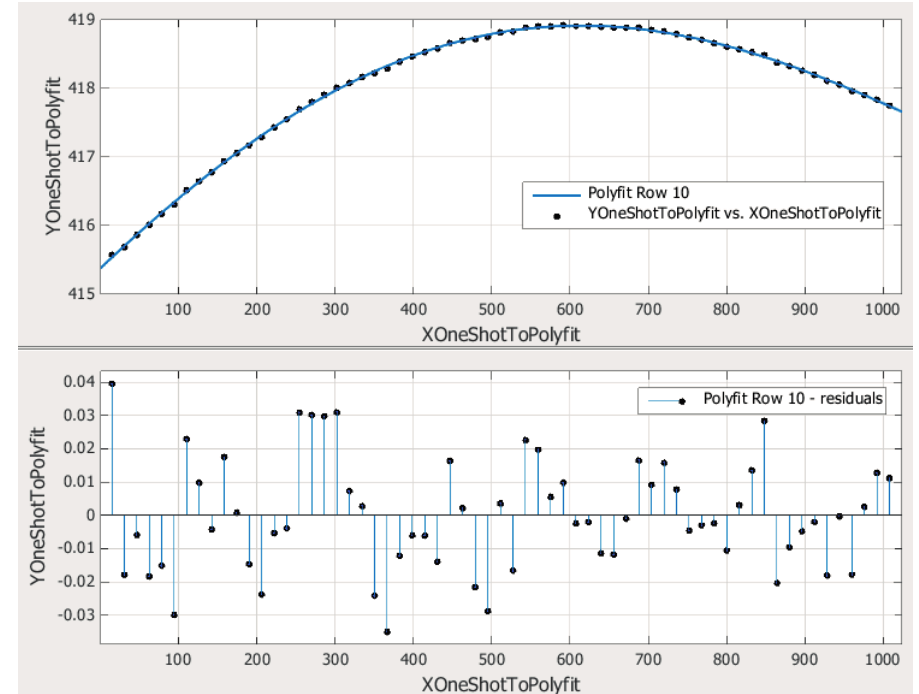
Figure 6. Final evaluation results of the polynomial